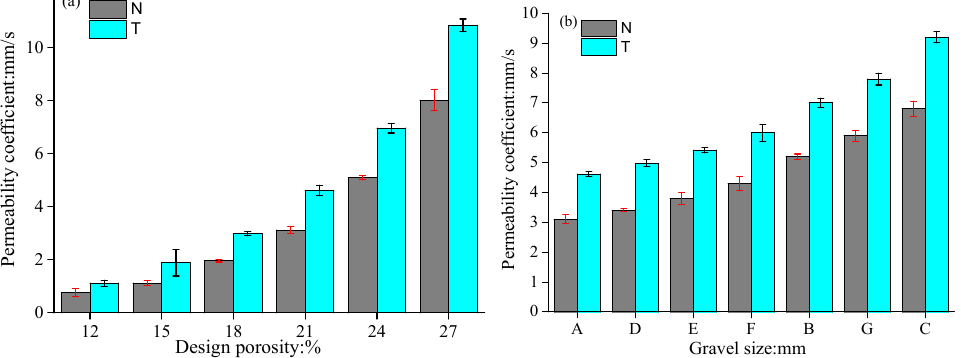
Figure 10. The permeability coefficient of permeable concrete under different test methods. ( a ) The design porosity of permeable concrete with 4.75–9.5 mm aggregate sizes; ( b ) the aggregate size of permeable concrete with 21% design porosity. The figure shows the average value and standard deviation of three specimens.